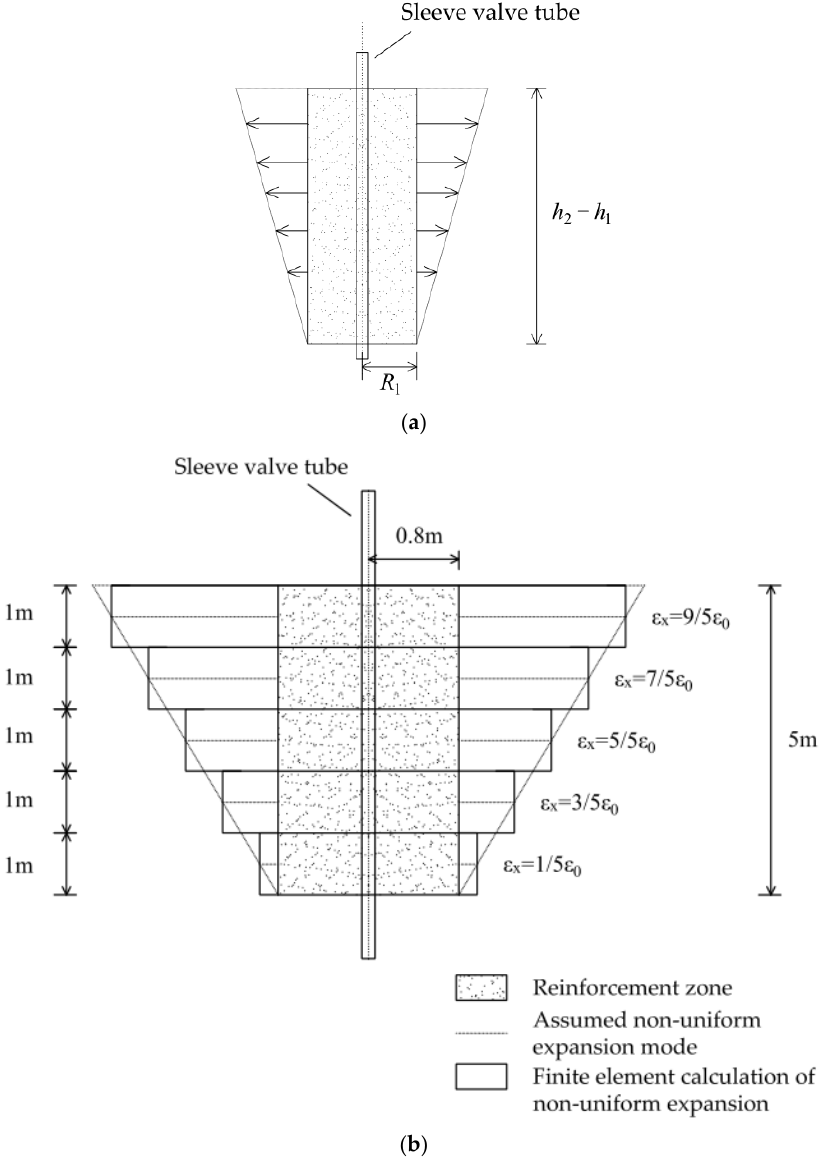
Figure 4. ( a ) The nonuniform expansion model of grouting; ( b ) the nonuniform expansion model of grouting used in the finite element method.